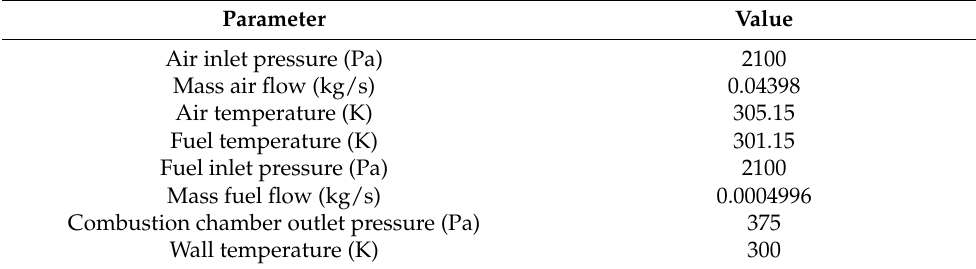
Figure 4. Mesh of fluid volume in the combustion chamber: ( a ) face size application; ( b ) swirler vane after using edge sizing number tool. Table 2. Boundary conditions for numerical analysis.